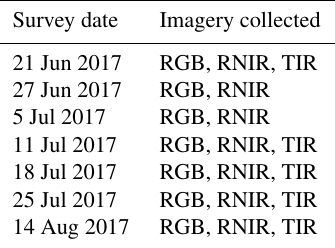
Table 1. List of all survey-flight dates and imagery collected. TIR imagery was not collected on 27 June and 5 July due to deteriorating weather conditions and early